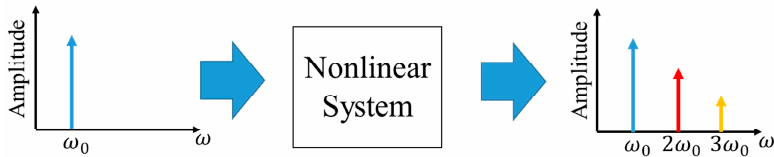
Figure 1. Illustration of the output due to a single frequency input into a nonlinear system.